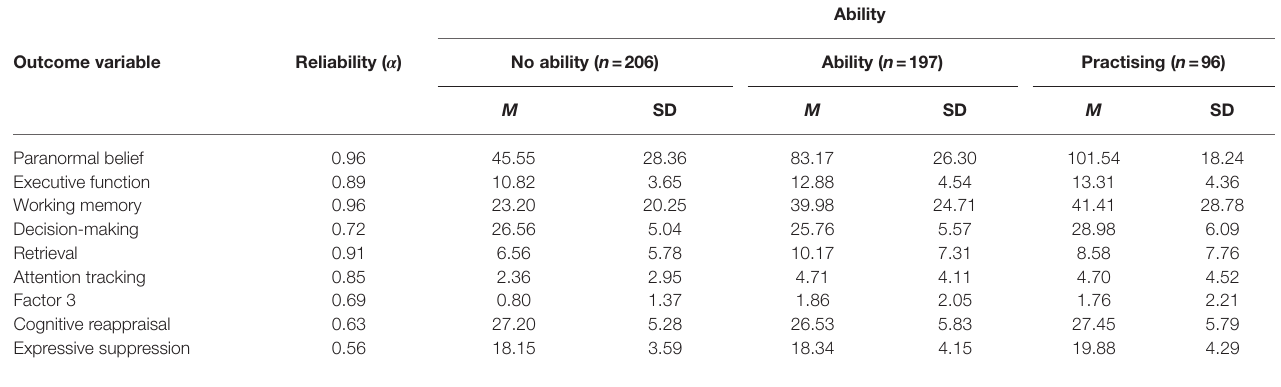
TABLE 2 | Reliability, means and standard deviations for paranormal belief and neuropsychological measures as a function of ability.